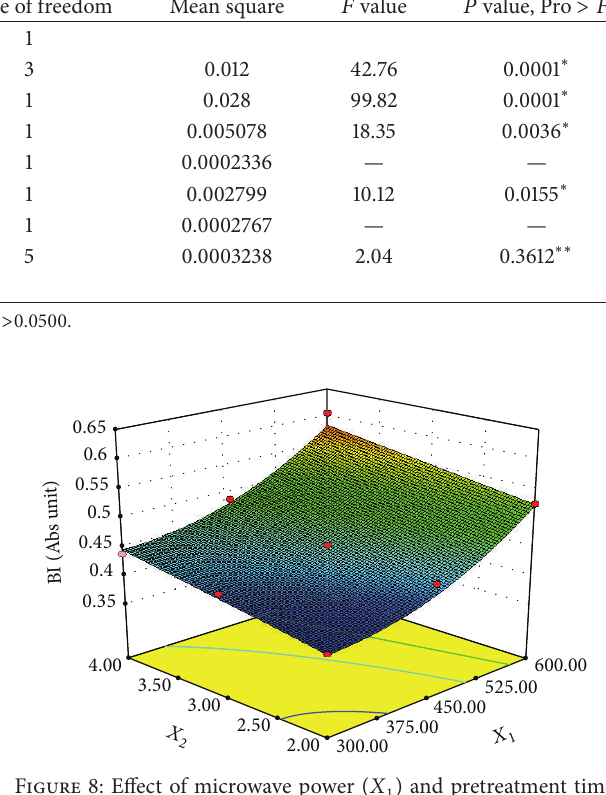
Figure 8: Effect of microwave power ( 𝑋 1 ) and pretreatment time ( 𝑋 2 ) on BI.